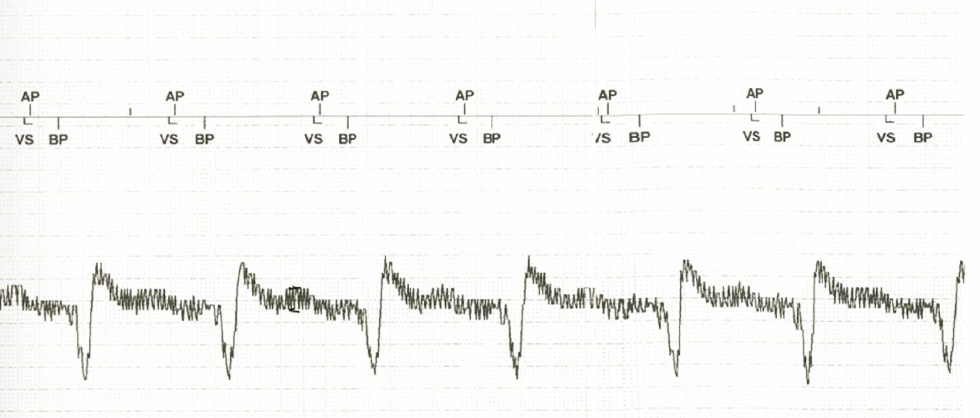
Figure 2: Pacing in asynchronous (DOO) mode with oversensing (marker annotations not a ff ecting pacing mode) seen prior to the A paced